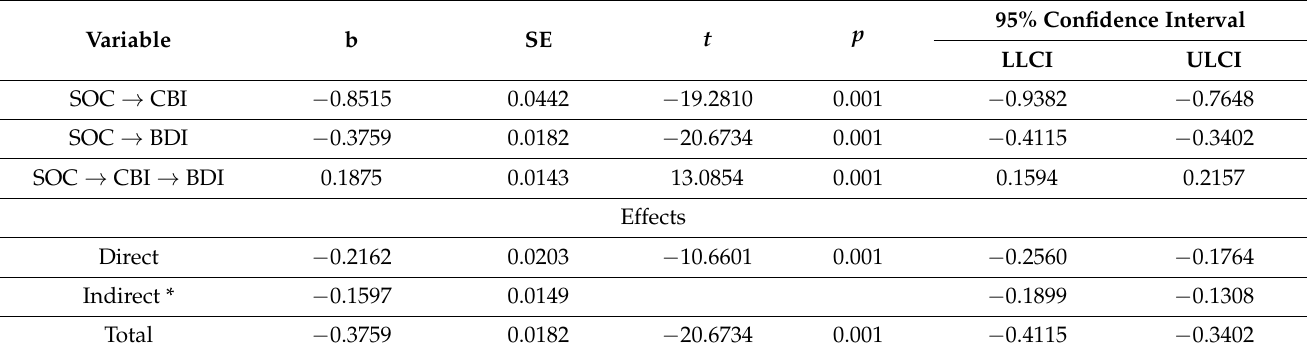
Table 4. Mediation analysis of Copenhagen Burnout Inventory (CBI) on Sense of Coherence (SOC)– Beck Depression Inventory (BDI) relationship.